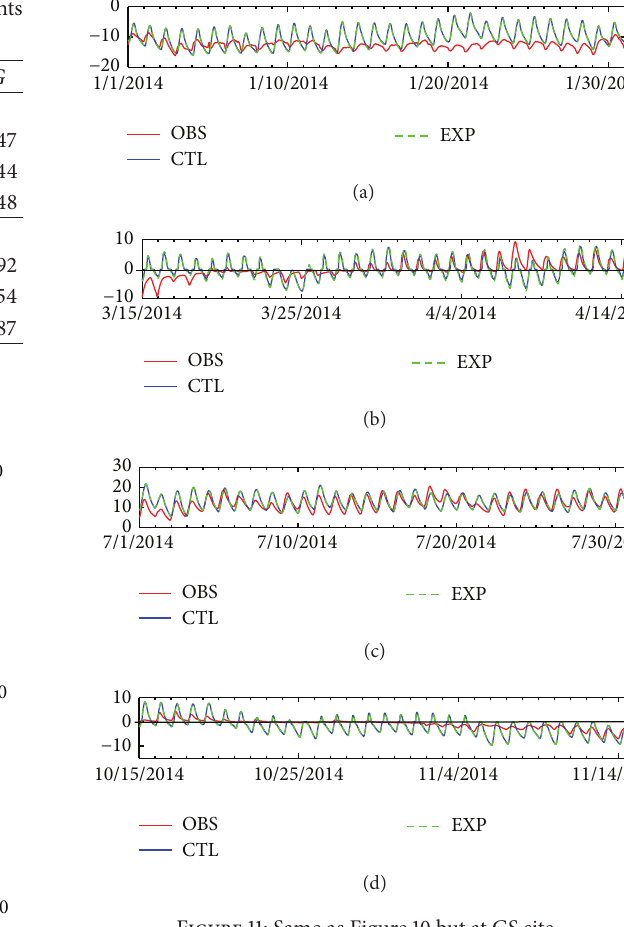
Figure 11: Same as Figure 10 but at GS